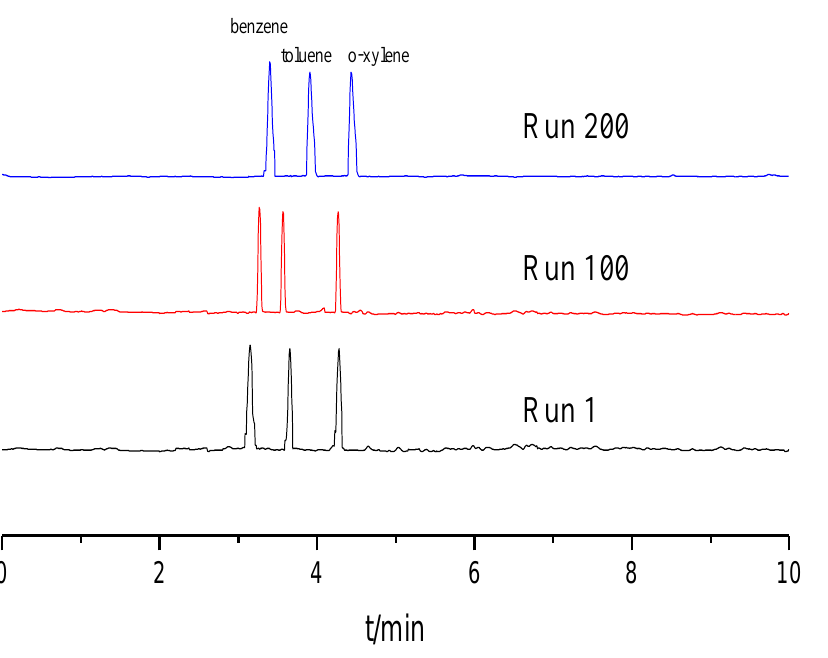
Figure 6. Separation chromatograms for benzene, toluene and o-xylene with different runs. Experi- mental conditions: sample, 5.0 mg/mL benzene; 5.0 mg/mL the mixture solution of benzene, toluene and o-xylene; 20 mM of phosphate buffer solution; operating voltage, 15 kV; temperature, 20 °C.